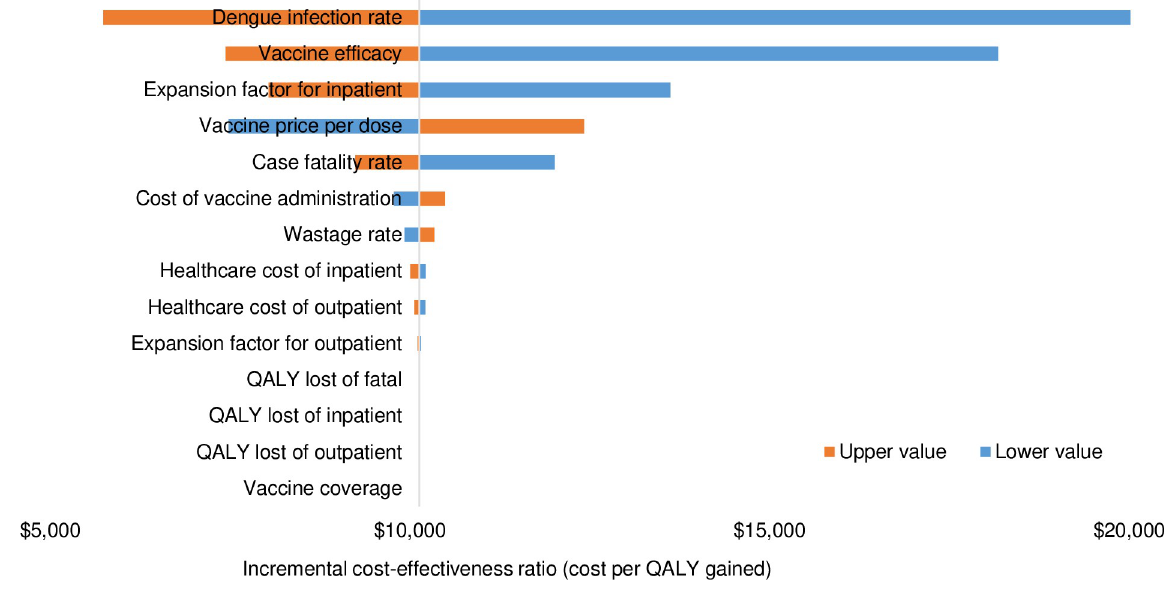
Fig 4. One-way sensitivity